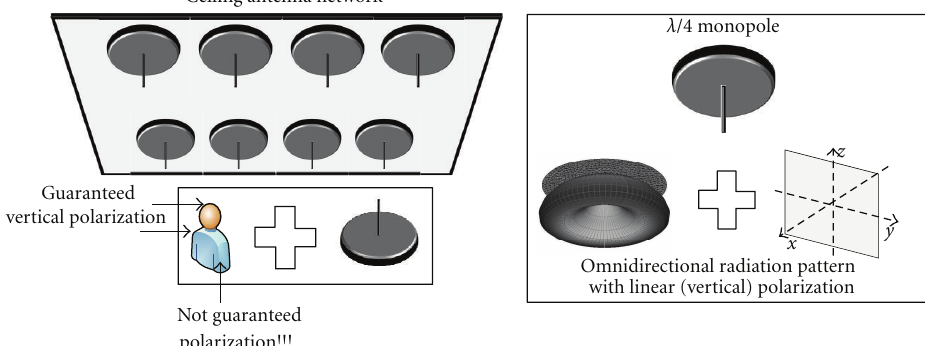
Figure 6: Monopole impact according to user integration position.